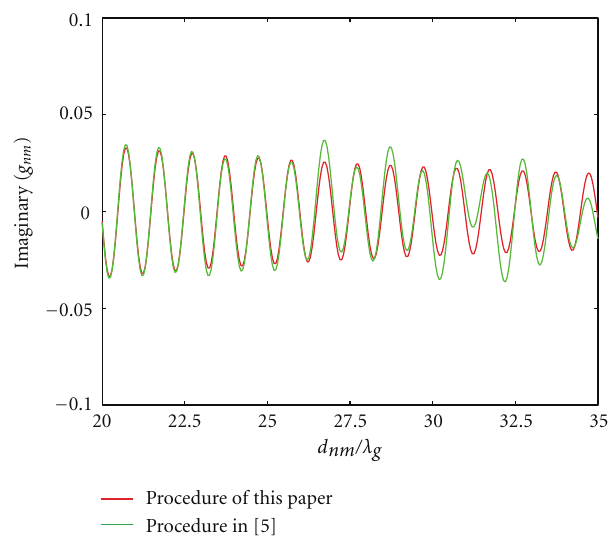
Figure 9: Imaginary part of the mutual coupling coe ffi cient g nm , θ = 90 ◦ . The results for d nm < 20 λ g are not shown since the curves virtually overlap.